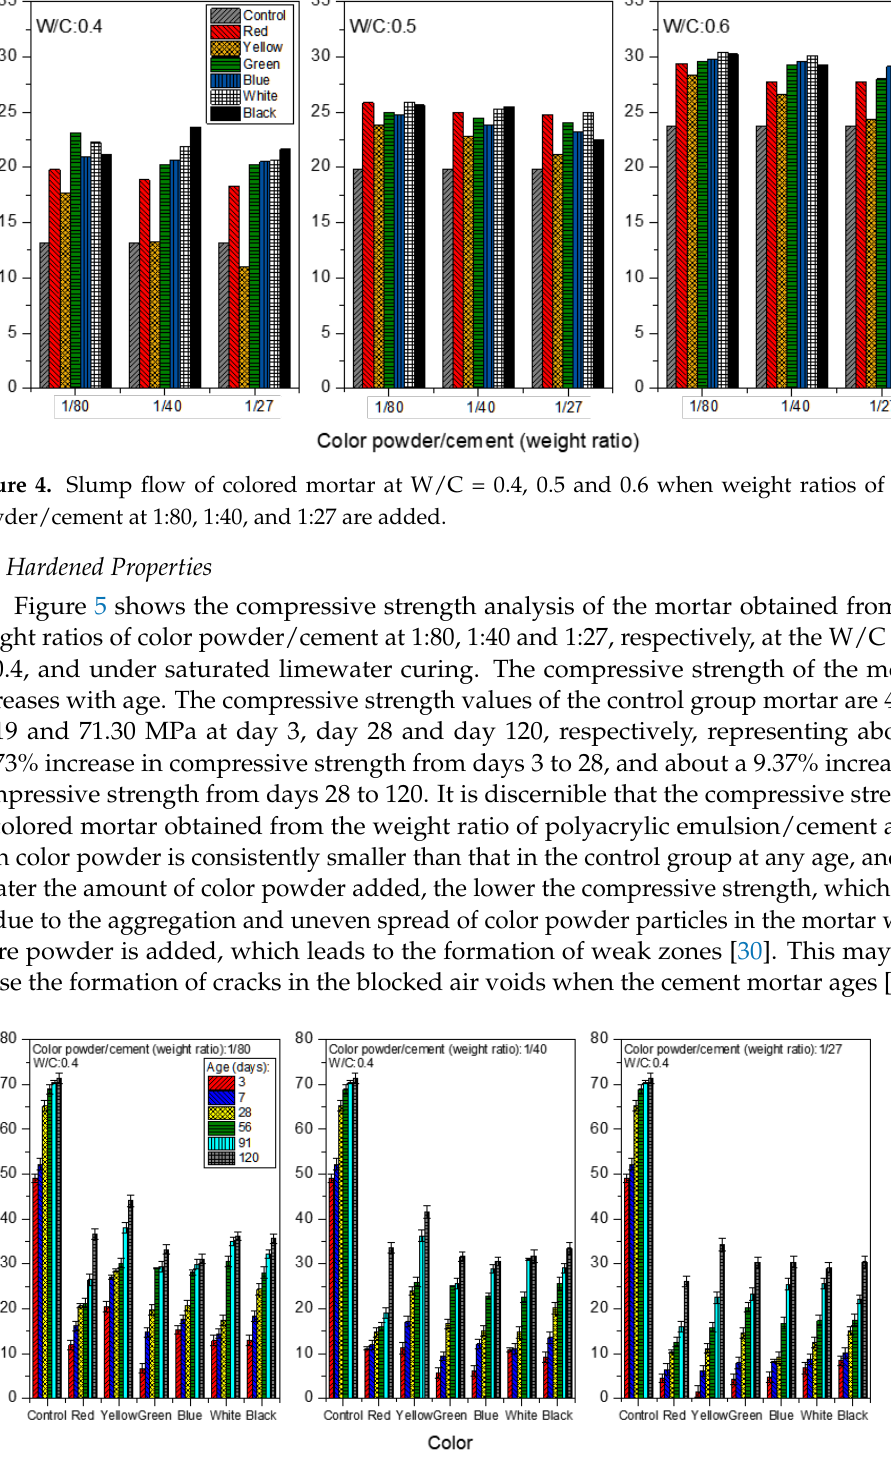
Figure 5. Compressive strength of colored mortar at W/C = 0.4 and under saturated limewater cur- ing when weight ratios of color powder/cement at 1:80, 1:40, and 1:27 are